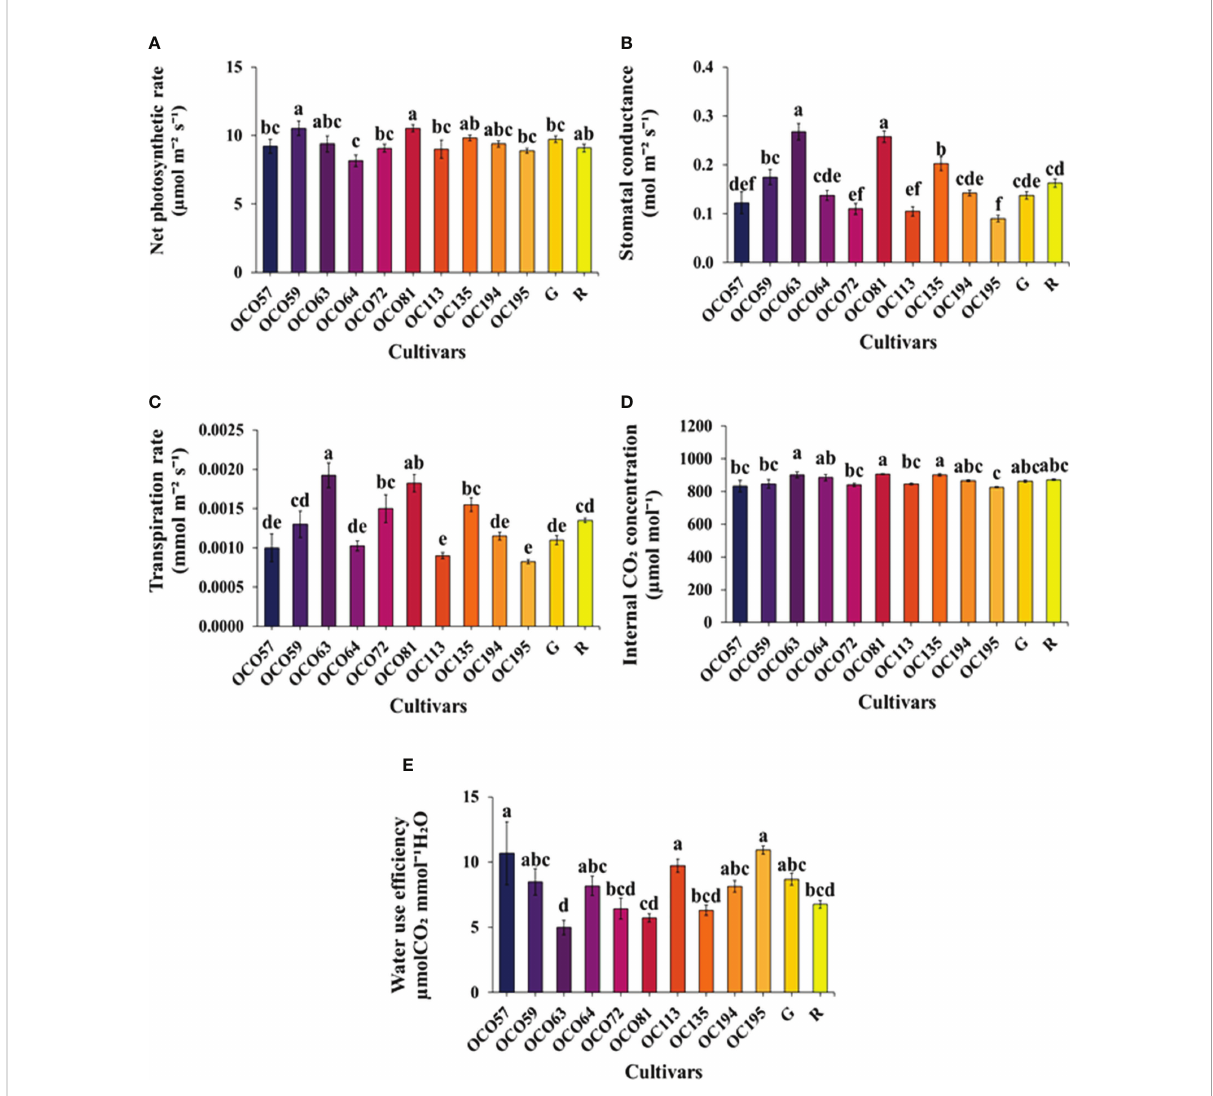
FIGURE 3 Leaf gas exchange parameters, net photosynthesis rate [ Pn , (A) ], stomatal conductance [ gsw , (B) ], transpiration rate [ E , (C) ], internal CO2 concentration [ Ci , (D) ], and water use ef fi ciency [ WUE , (E) ] of Thai holy basil cultivars/accessions at the fl owering stage. R and G represent the red and green commercial cultivars, respectively. Bars represent standard error. Values are represented as mean ± SE ( n = 4). ANOVA was performed, followed by a mean comparison with DMRT . Letters above bars show the signi fi cant difference of means at P <